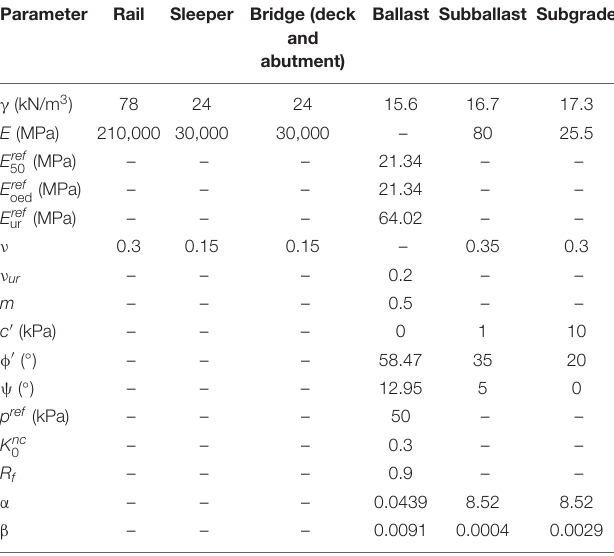
TABLE 1 | Material parameters used in the